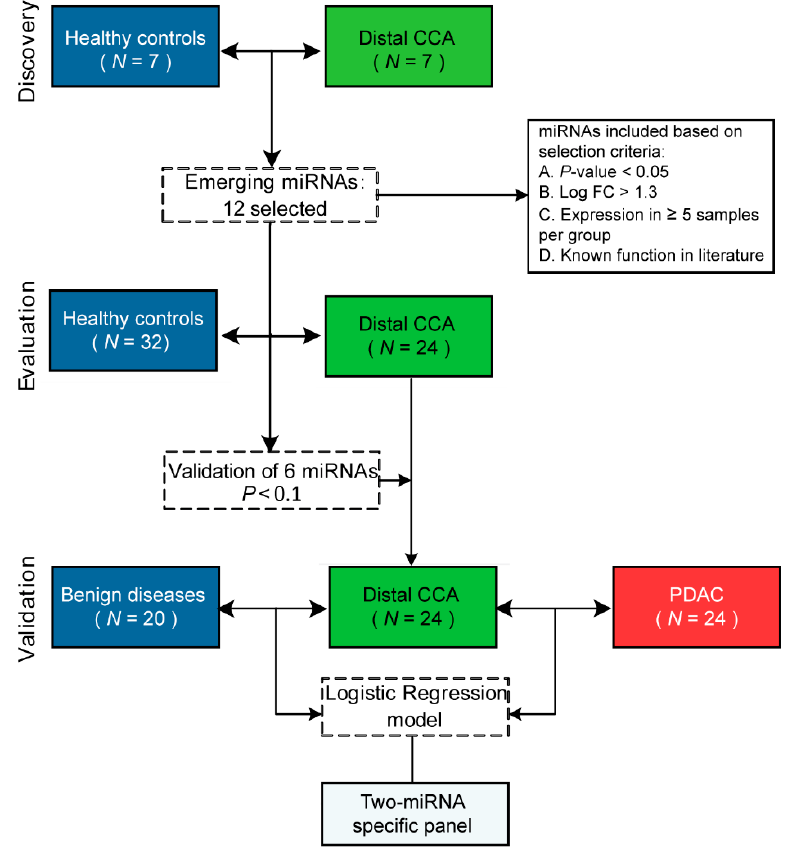
Figure 1. Study design and selection of candidate miRNAs. In the initial discovery phase, PCR panel profiling was performed on seven consecutive patients with distal CCA and seven age- and sex-matched healthy controls. Based on predefined selection criteria, twelve miRNAs were selected for evaluation by RT-qPCR. Of these, six miRNAs were validated to be di ff erentially expressed between distal CCA and healthy controls. These six miRNAs were further validated in the validation phase in patients with distal CCA, benign disease, and PDAC. Distal CCA = distal cholangiocarcinoma, PDAC = pancreatic ductal adenocarcinoma, miRNA = microRNA, Log FC = Log fold change.